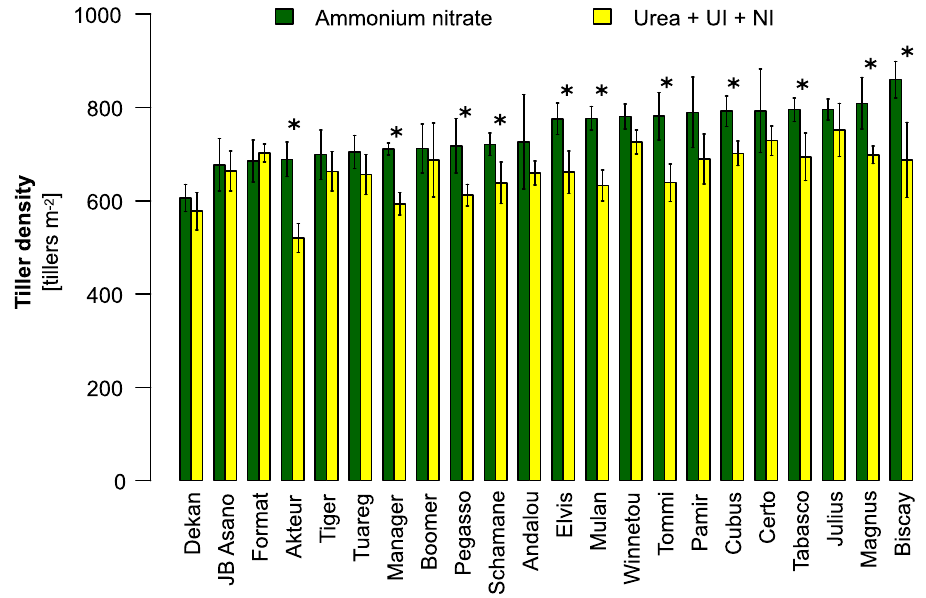
Figure 5. Genotypic variation of tiller formation in 22 field-grown winter wheat cultivars in dependence of the form of N nutrition. Tiller density was determined at the end of vegetative development (BBCH 31) of winter wheat plants supplemented with 80 kg N ha −1 as starter dressing in the form of urea plus urease inhibitor (UI) and nitrification inhibitor (NI), providing urea-dominated N supply, or ammonium nitrate (nitrate- dominated N supply). Plants were grown on the site Gatersleben in 2009/2010. Bars represent means ± SD, n = 4 independent replicate plots. Asterisks indicate significant differences among fertilizer treatments at p < 0.05 by Tukey’s